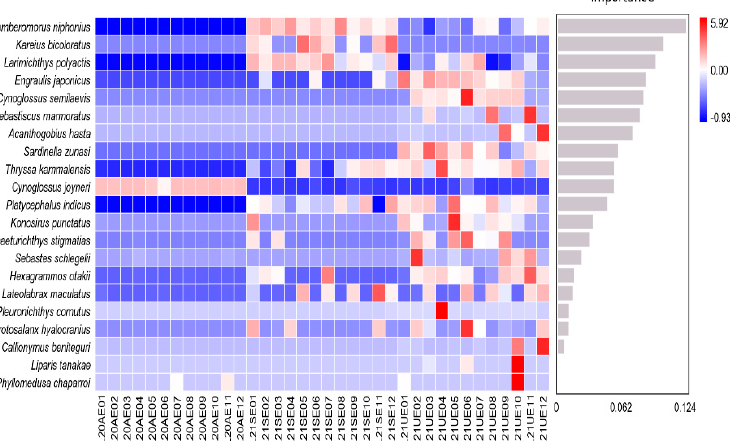
Figure 2. Scatter diagram of random forest analysis. The horizontal coordinates of the bars in the figure represent the importance scoring values of lifeforms to the classification algorithm, and the lateral coordinates are the names of taxonomic units at the species identification; the heatmap demonstrates the variation of an abundant supply of these lifeforms across samples/groups. The relevance of organisms to the framework declines from up to down; organisms at the top of the value scale might be regarded as indicator species for inter-group disparities. Table 3. Dominant species in each season.